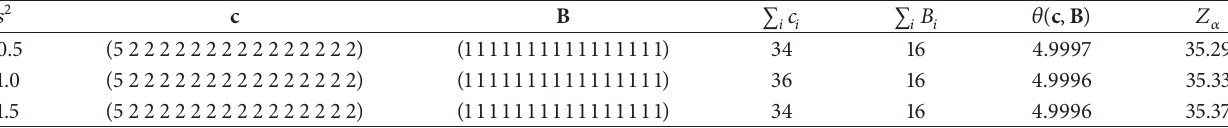
Table 2: Results for the server allocation problem.